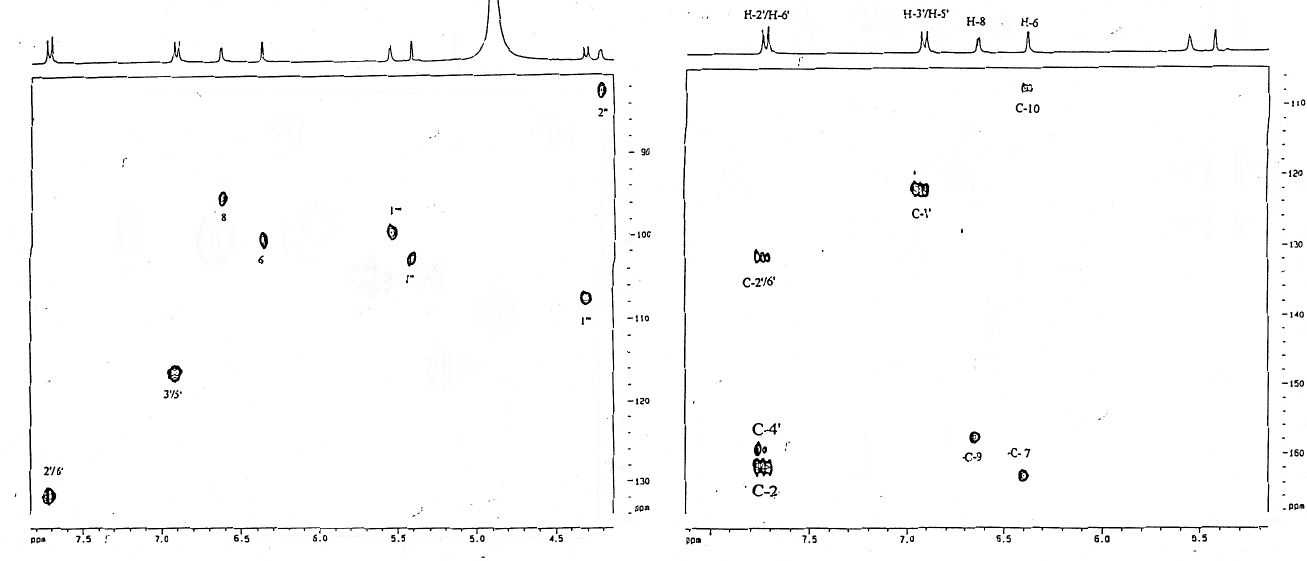
Figure S5: HMQC spectrum of sagittatin A (300 MHz; CD 3 OD). Magnification of 4.0 - 8.0/80 -140 ppm region.